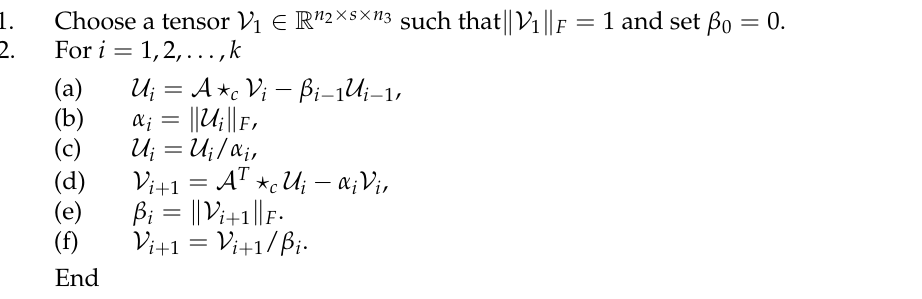
Algorithm 3 The Tensor Global Golub–Kahan algorithm